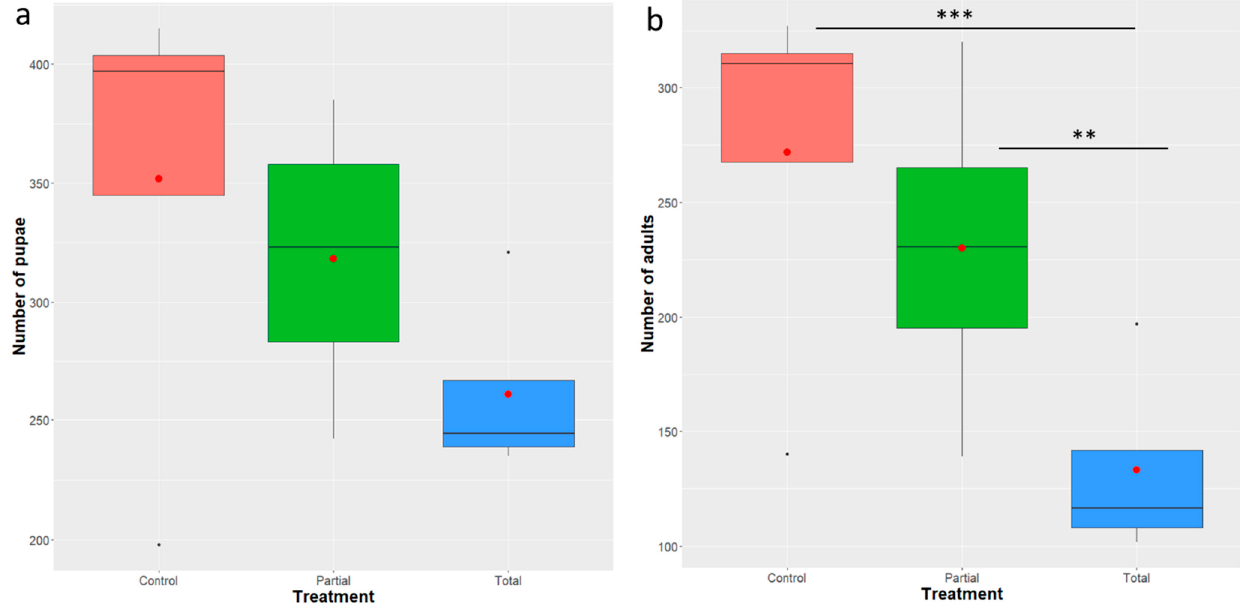
Figure 2. Effect of Enterobacter sp. AA26 on pupal and adult recovery. A GLM (negative binomial family) was used to analyze the impact of the various treatments on the recovery of pupae and adults; ( a ). Number of pupae recovered per treatment; ( b ). Number of adults recovered per treatment. Boxplots span the interquartile range and whiskers indicate the highest and lowest observations. The line and the dot inside each box represent the median and the mean, respectively. Significant differences between treatment groups are indicated with asterisks (*** p ≤ 0.001, ** p ≤ 0.01, * p ≤ 0.05, ns: p > 0.05; confidence level used: 0.95, alpha = 0.05).